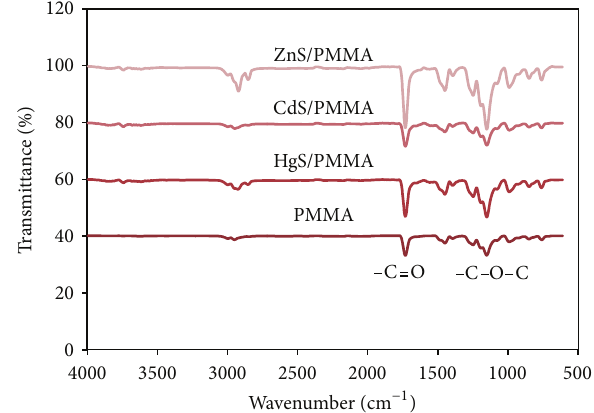
Figure 1: The FTIR spectra of PMMA and its metal sulfides/PMMA